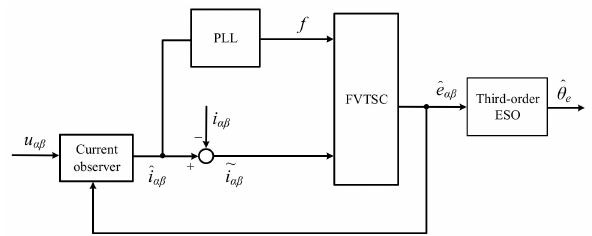
Figure 7. Overall implementation block diagram of the improved SMO.